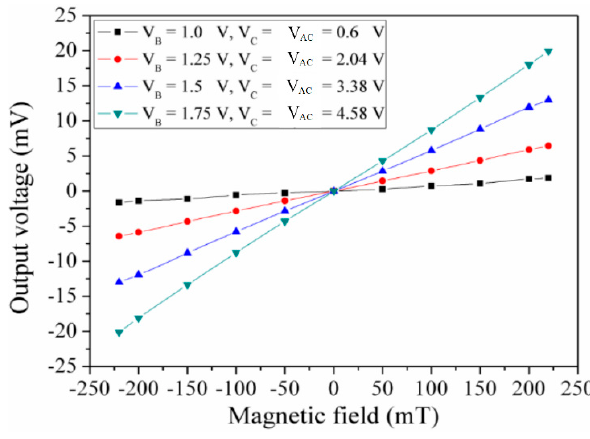
Figure 11. Measured output voltage in the z ‐ direction MF.